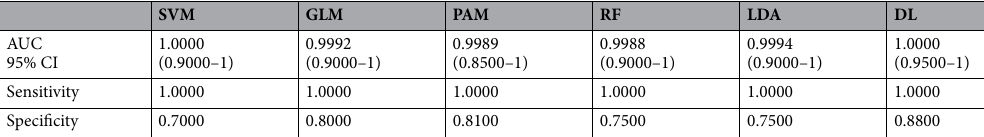
Table 3. Ovarian cancer prediction based on cell free DNA: Artificial intelligence with cross validation (top 25 variables). Support Vector Machine (SVM), Generalized Linear Model (GLM), Prediction Analysis for Microarrays (PAM), Random Forest (RF), Linear Discriminant Analysis (LDA) and Deep Learning (DL). Important predictors in order: SVM: cg22563825, cg16474643, cg05476766, cg20675030,